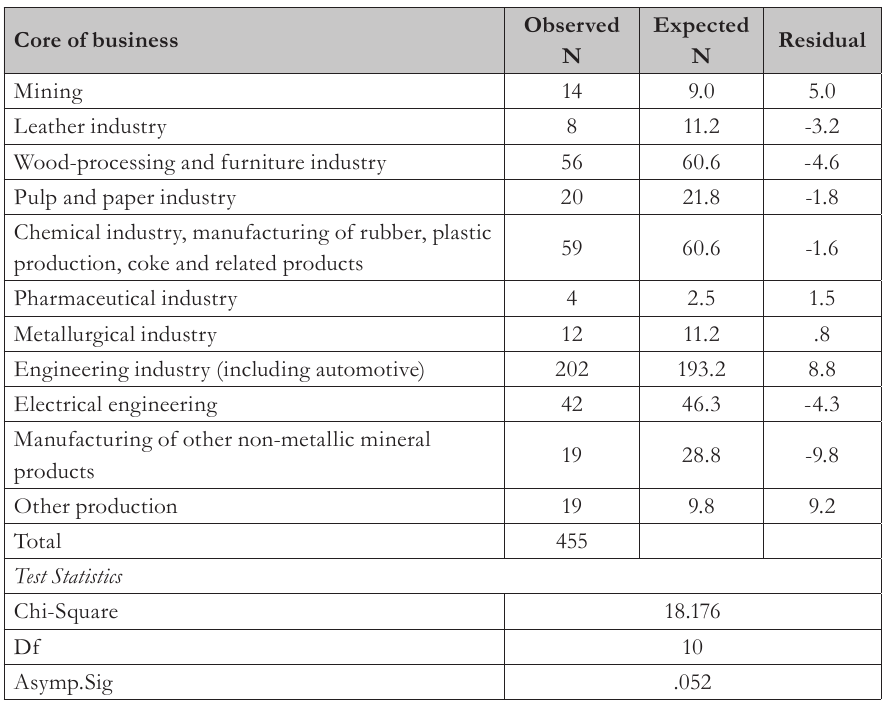
Tab. 3 - Verification of representativeness of the sample used by main areas of the